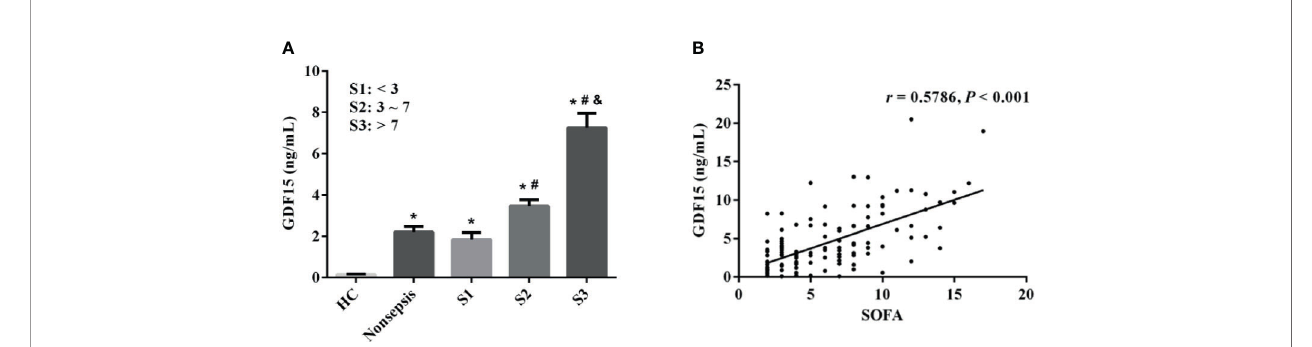
FIGURE 3 | Correlation between GDF15 and SOFA scores in patients with sepsis. (A) comparison of GDF15 levels in sepsis patients with different SOFA scores; (B) Spearman correlation analysis of SOFA scores and GDF15. * P < 0.05, compare with HC group; # P < 0.05, compare with S1 group; & P < 0.05, compare with S2 group.